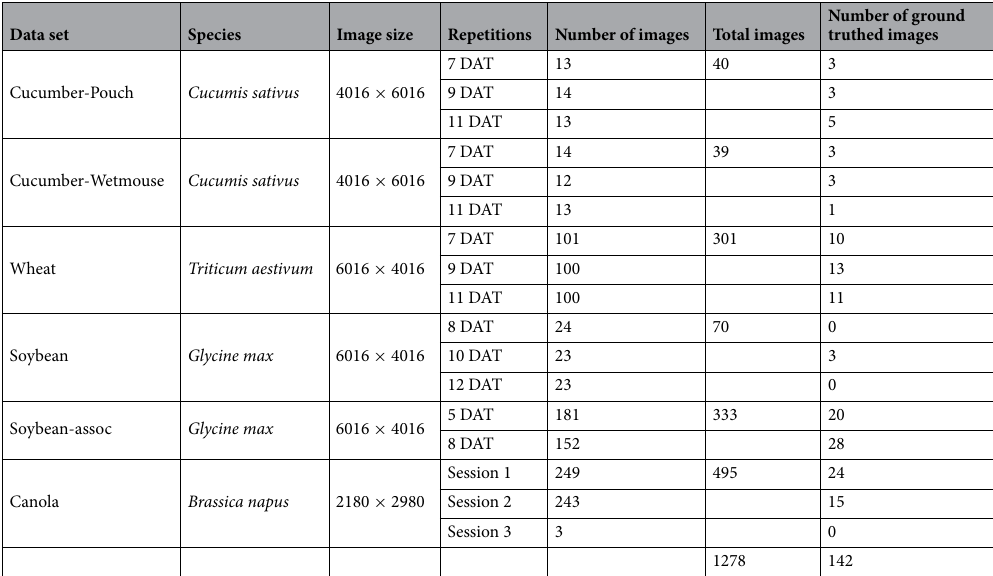
Table 1. Data set summay. In the “Repetitions” column, DAT indicates the number of days after transplantation that the imaging took place, while in the case of the canola dataset, each session was taken four days apart, but the number of days afer transplantation is not